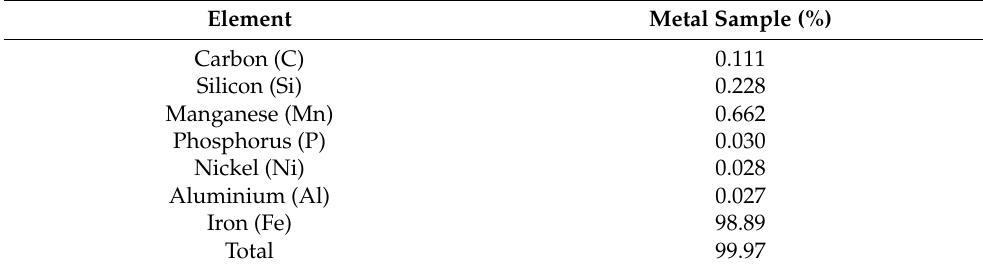
Table A3. Spark spectrometry analysis of API-5LX52 carbon steel.